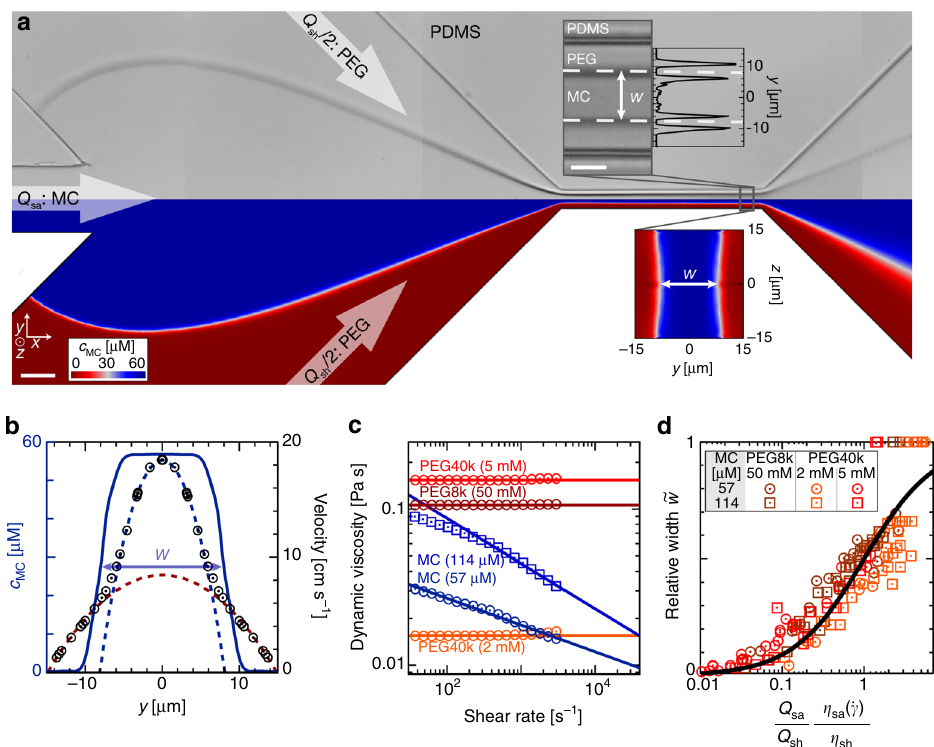
Fig. 1 Virtual fl uidic channel inside micro fl uidic chip. a Micro fl uidic chip as stitched microscopy image (upper half) and as the concentration plot of a fi nite element method (FEM) simulation of the full geometry (lower half). Arrows indicate in fl ow of 57 µ M methylcellulose in PBS (MC, fl ow rate Q sa = 48 nl s − 1 ) and 50 mM polyethylene glycol 8000 in PBS (PEG8000, fl ow rate Q sh = 8 nl s − 1 ) forming a stable virtual fl uidic channel between two liquid – liquid interfaces represented in dark gray (upper half) and in white (lower half). Scale bar is 50 µ m. Top inset shows a bright- fi eld image of the central constriction and the projected squared intensity gradient (arb. units) across the full channel width. Virtual channel width corresponds to distance w (white dashed lines) between the center of both intensity maxima. Scale bar is 10 µ m. Bottom inset shows a cross-sectional view of the calculated (FEM) polymer concentration inside the channel. b Velocity pro fi le (black circles) inside the center of the constriction derived from FEM simulations with the corresponding MC concentration distribution (blue solid line) used to identify the virtual channel width w . The red and the blue dashed lines indicate the parabolic fl ow pro fi les of the outer and inner aqueous phases. c Dynamic viscosities of sample and sheath solutions as a function of shear rate. Virtual channel formation is performed using MC as sample buffer (blue) and PEG as sheath buffer (dark red, orange, bright red). Data points are measured and for shear rates greater than 3000 s − 1 the shear-rate dependency is modeled as a power-law fl uid (solid blue line) and as Newtonian fl uid (solid orange and red lines). d Relative virtual channel width ~ w as a function of fl ow rate and viscosity ratios. The plot summarizes n = 146 experiments using different concentrations of MC, PEG8000 (PEG8K), and PEG40000 (PEG40K) for sample and sheath solution. The black curve is a solution to Eq. inner and outer aqueous phase (Fig. 1b, blue and red dashed line), respectively 37 . The velocity gradient of the resulting piecewise- de fi ned Poiseuille fl ow (Fig. 1b, black circles) is given by the viscosity mismatch of both polymer solutions (Fig. 1c) where the MC phase corresponds to an effective (virtual) channel size smaller than the cross-section of the PDMS chip.